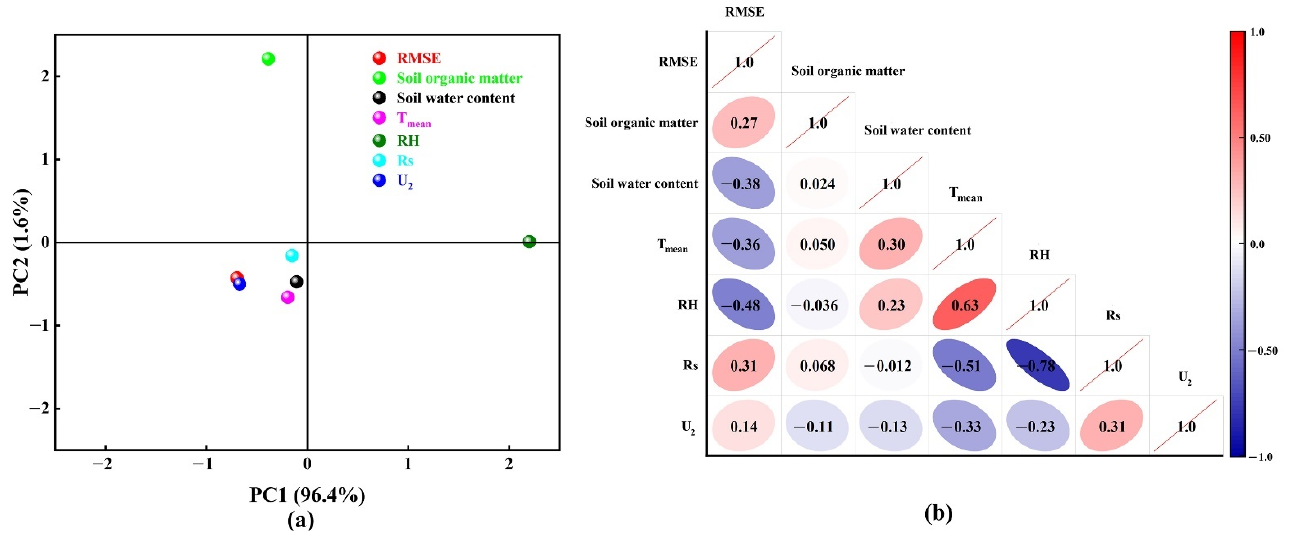
Figure 8. Principal component analysis ( a ) and correlation analysis ( b ) between several factors and model estimation T s errors.